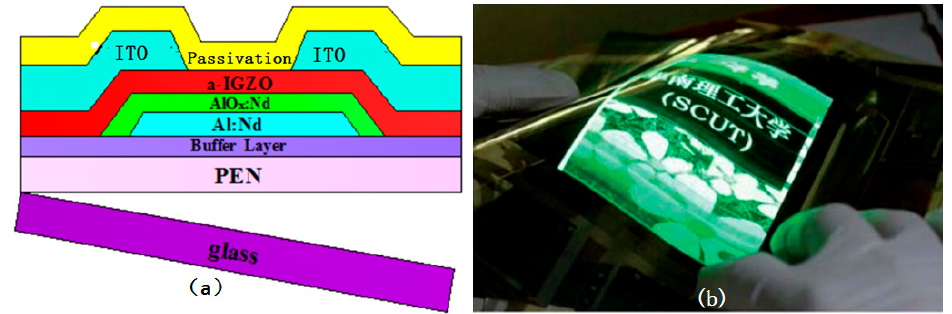
Figure 6. ( a ) Schematic of TFT with the dielectric of anodized aluminum oxide. ( b ) AMOLED on a PEN substrate